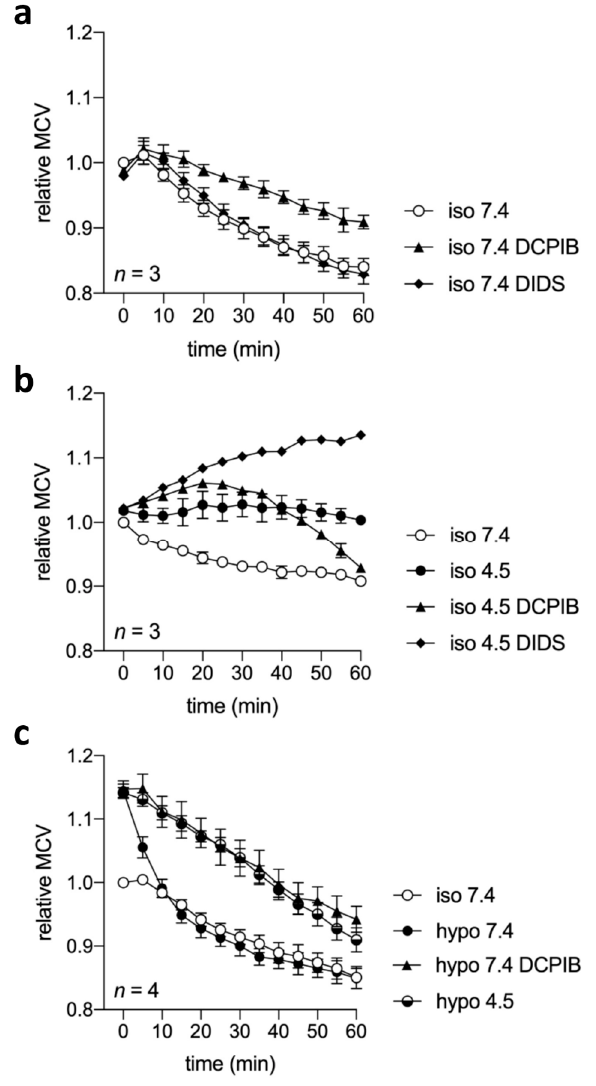
Figure 8. Cell volume regulation in BV-2 cells under normal pH 7.4 or acidic pH 4.5 under isotonic (iso) or hypotonic (hypo) conditions in absence or presence of Cl − channel blockers: Measurements were performed using the Coulter method. Mean cell volume (MCV) over time under ( a ) iso pH 7.4 in absence or presence of DCPIB or DIDS, ( b ) iso pH 7.4 or pH 4.5 in absence or presence of DCPIB or DIDS and ( c ) iso pH 7.4, hypo pH 4.5 in absence or presence of DCPIB and hypo pH 4.5. DIDS or DCPIB were added at 10 µM. Data are shown relative to the MCV in femtoliters (fl) of the first measurement under the respective condition.